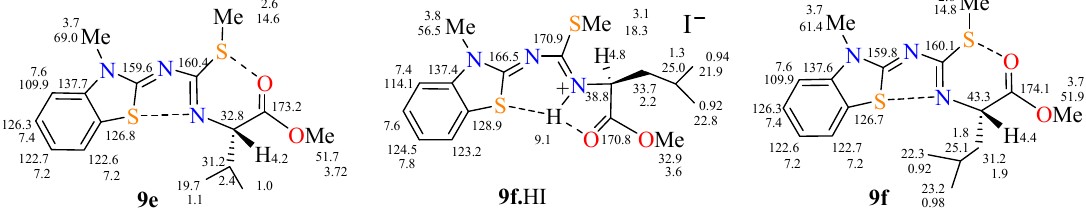
Figure 1. 1 H and 13 C NMR data in CDCl 3 of compounds 9e , 9f , and 9f HI.